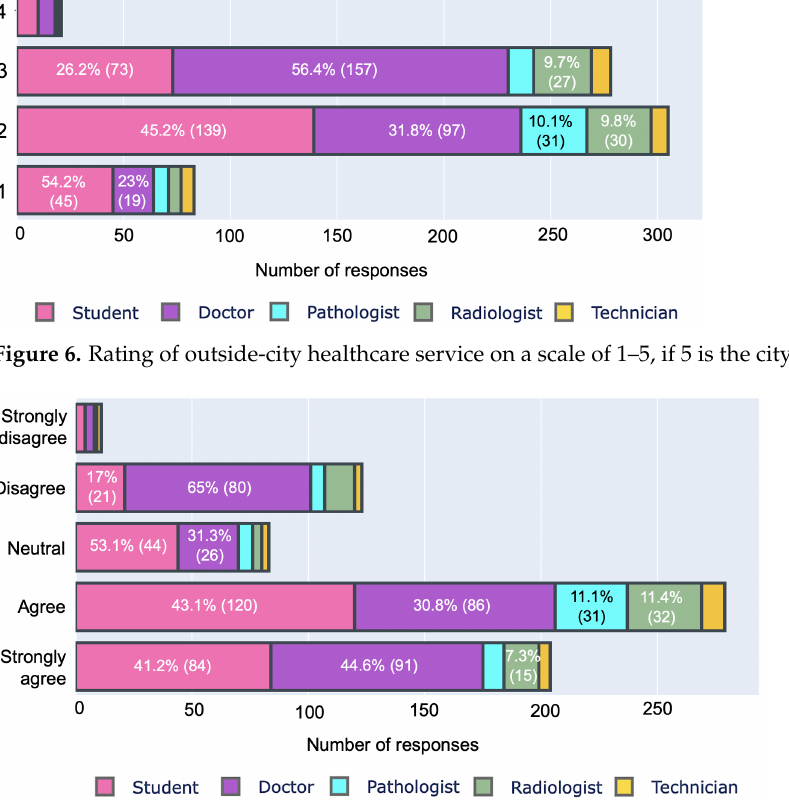
Figure 7. Digitalization for improving healthcare services of rural and remote